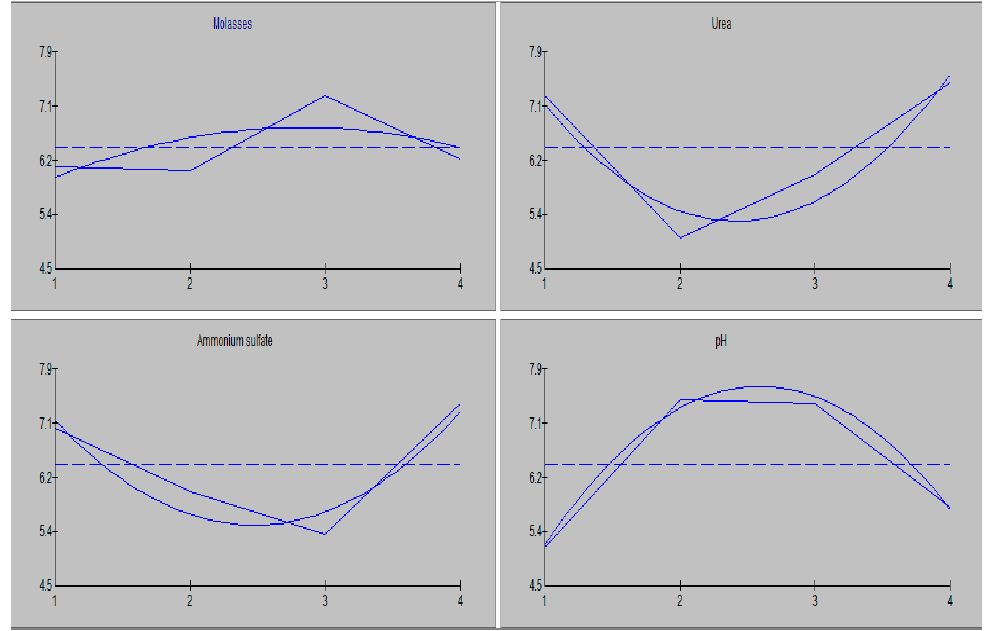
Figure 4. Determine the best level of four selected factors optimized by Qualitek-4 software.